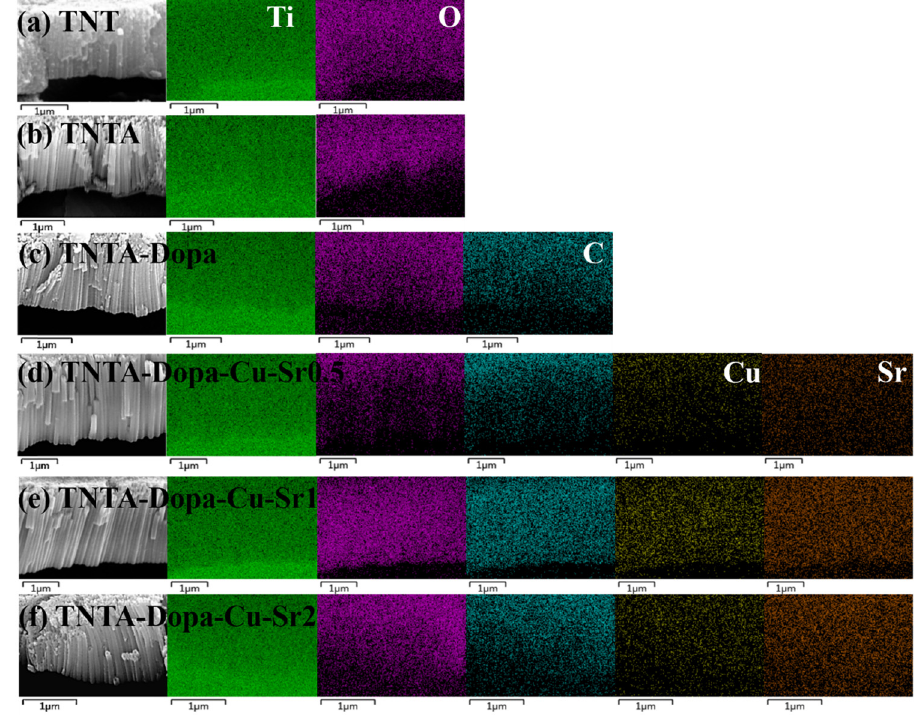
Figure 2: Cross - section morphologies and elements mapping of TNT ( a ) , TNTA ( b ) , TNTA - Dopa ( c ) , TNTA - Dopa - Cu - Sr0.5 ( d ) , TNTA - Dopa - Cu - Sr1 ( e ) , TNTA - Dopa - Cu - Sr2 ( f )